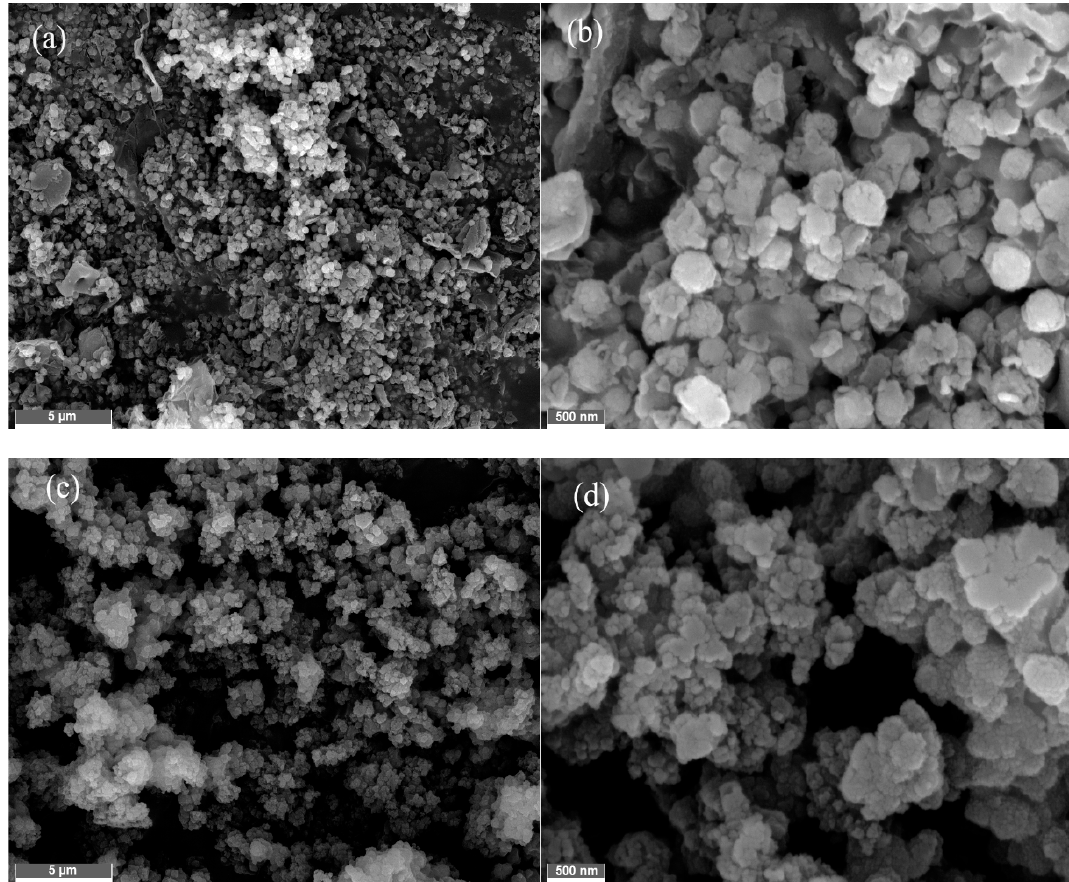
Figure 6. Morphologies of chalcopyrite specimens before leaching ( a , b ) and after chemical oxidation ( c , d ) as determined by SEM.